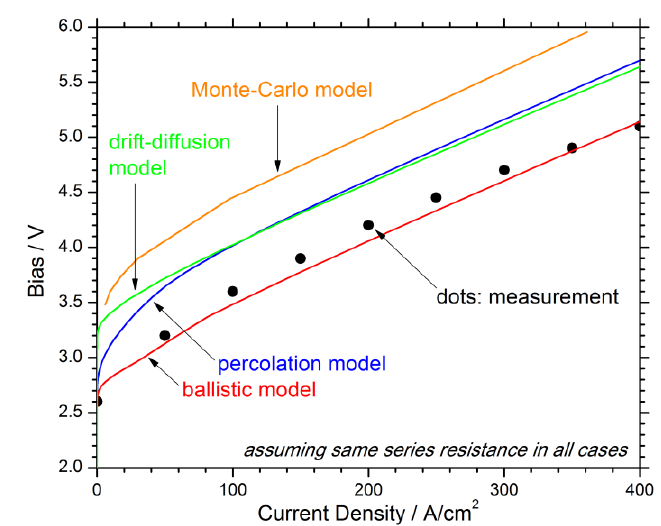
Figure 3. Comparison of bias-current characteristics calculated for the same LED structure with different transport models (see text).